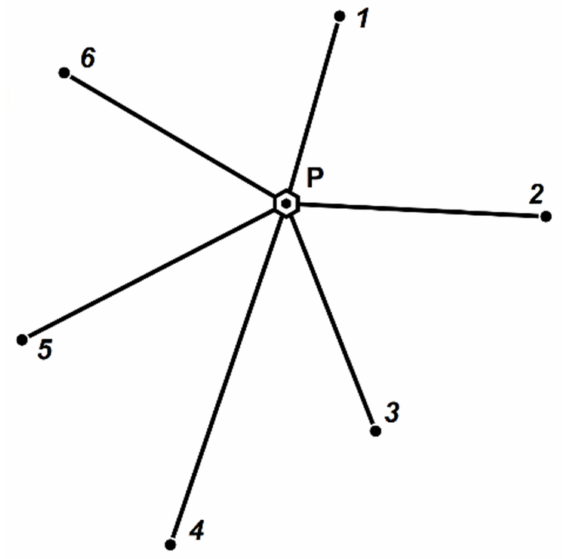
Figure 2. Example of point P positioning from six tie points (i = 1 ÷